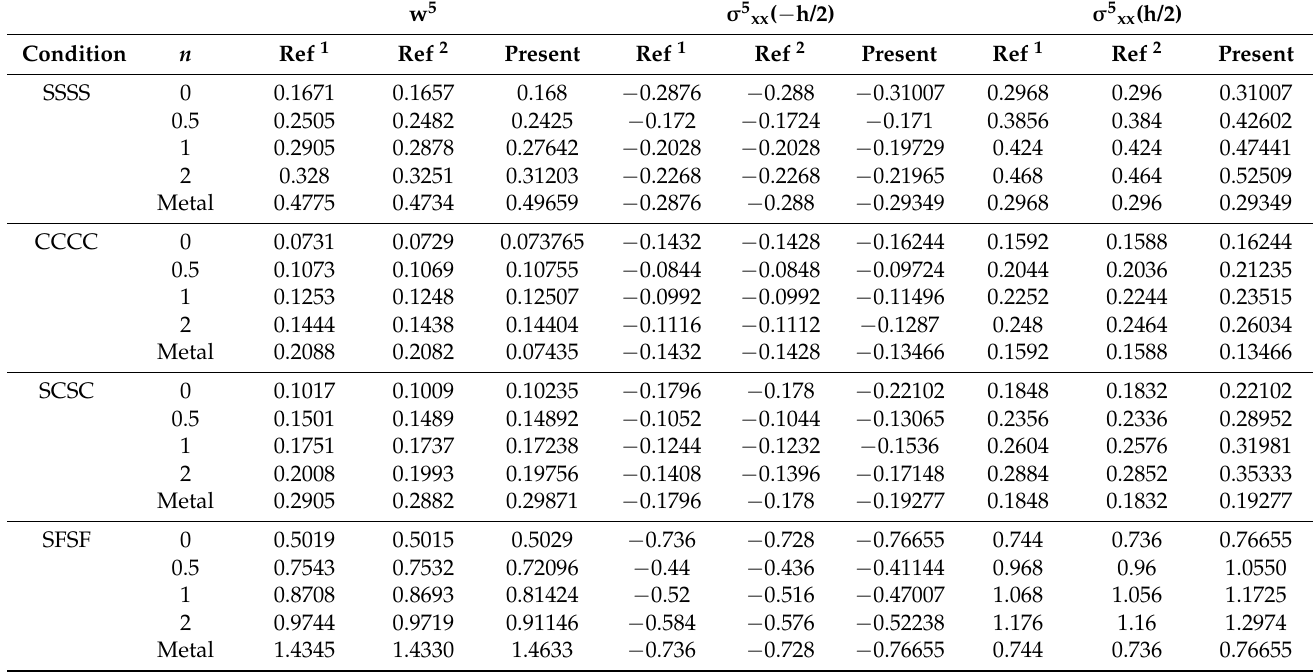
Table 8. Effect of the different boundary conditions on the non-dimensional central deflection and axial stress of an FGM plate subjected to uniformly distributed load. w 5 σ 5 xx ( − h/2) σ 5 xx